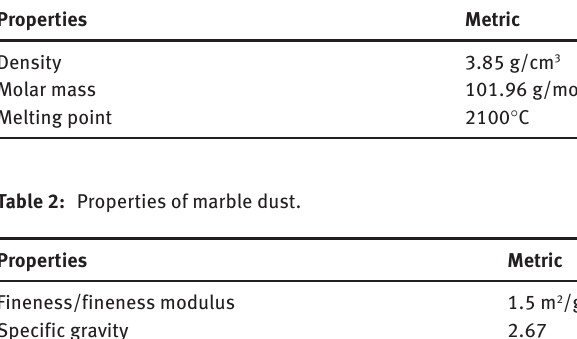
Table 4: Detailed composition of unfilled and particulate-filled dental